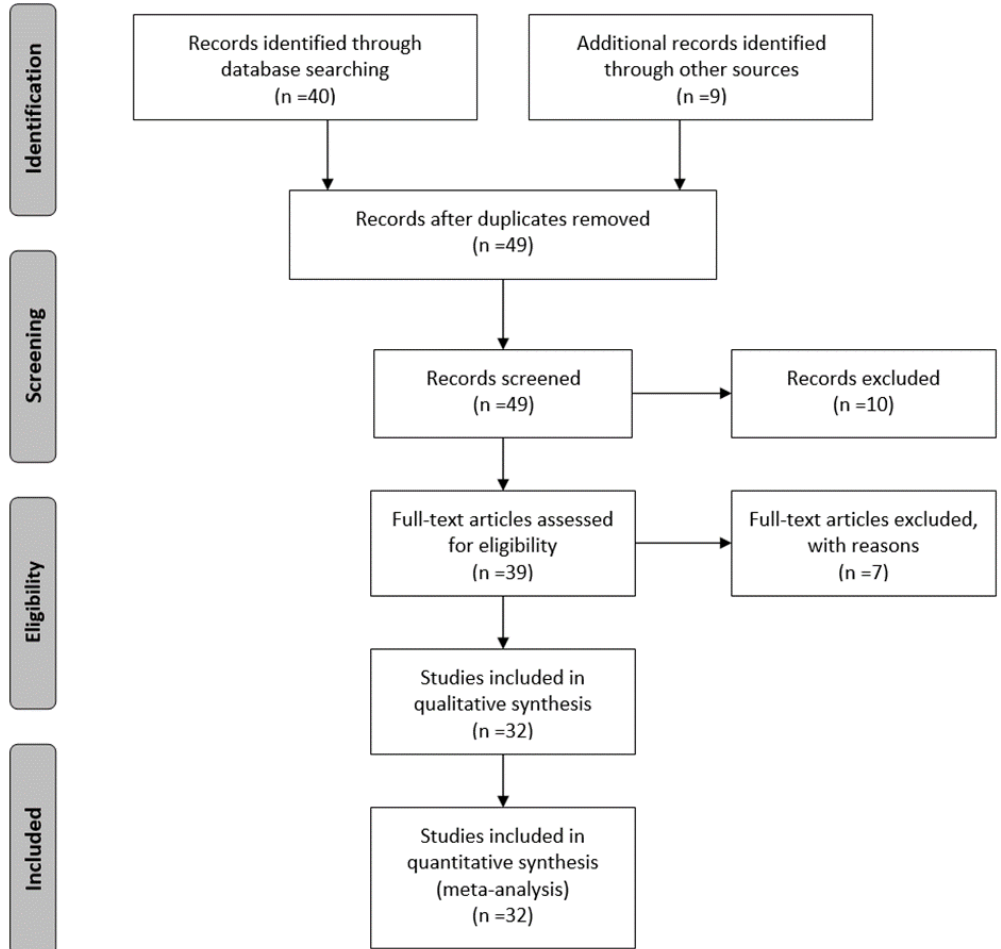
Figure 2. PRISMA flow diagram for the explored publications.